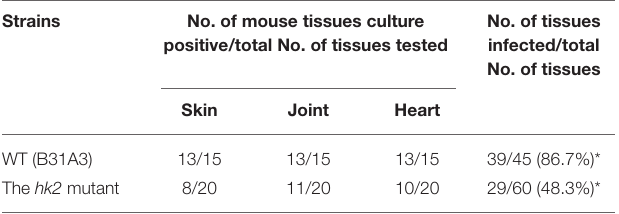
TABLE 1 | The infectivity of the hk2 mutant via tick bite ¶ . Strains No. of mouse tissues culture positive/total No. of tissues tested